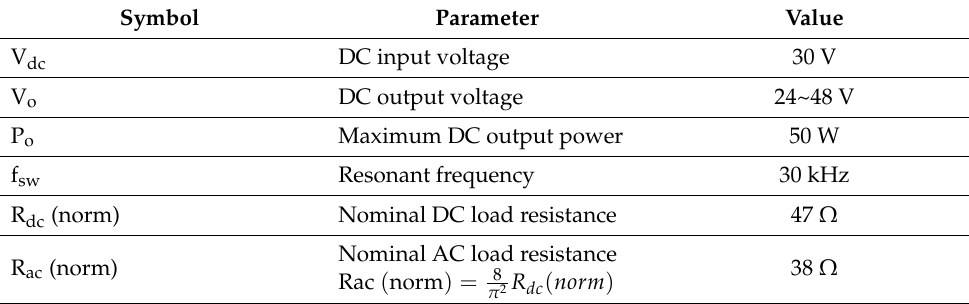
Table 4. Design requirement for LCC resonant converter.